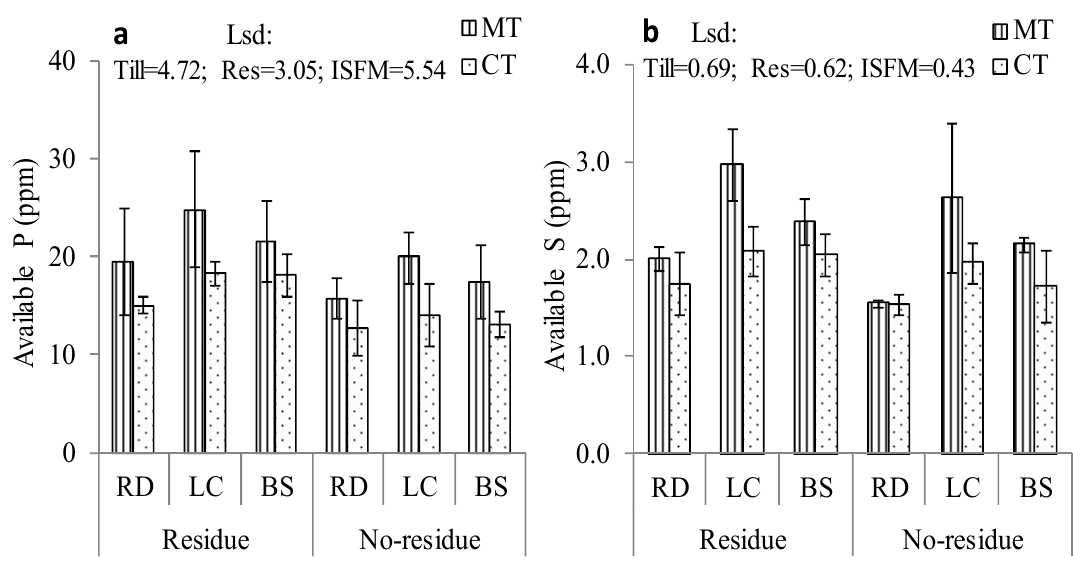
Figure 7. Post-harvest soil available P and S contents after two consecutive years ( a ) 2017 and ( b ) 2018 of ISFM with crop residue and tillage practices management impacts on post-harvest soil.